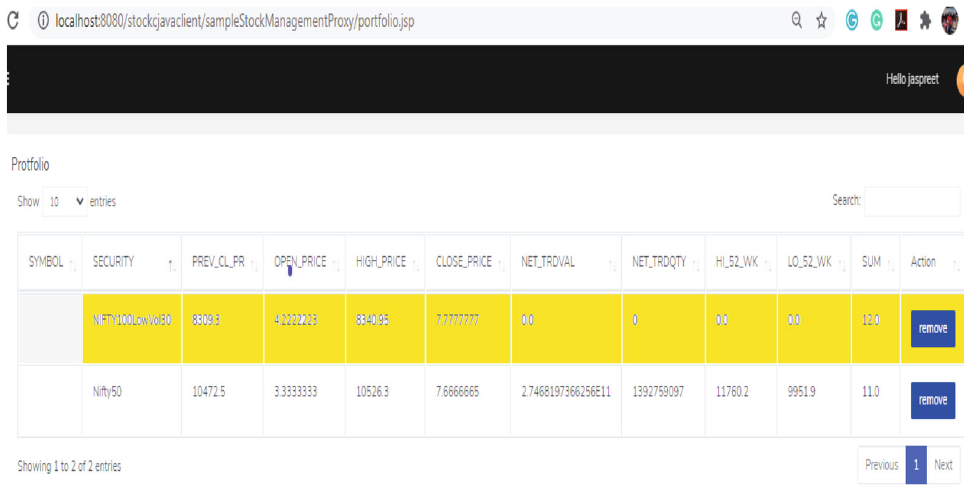
Figure 7: Precision issues in JAVA at the 7 th place after the decimal.